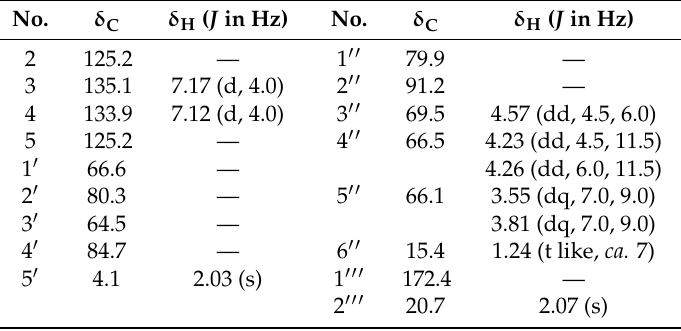
Table 4. 1 H- and 13 C-NMR data 4 in CD 3